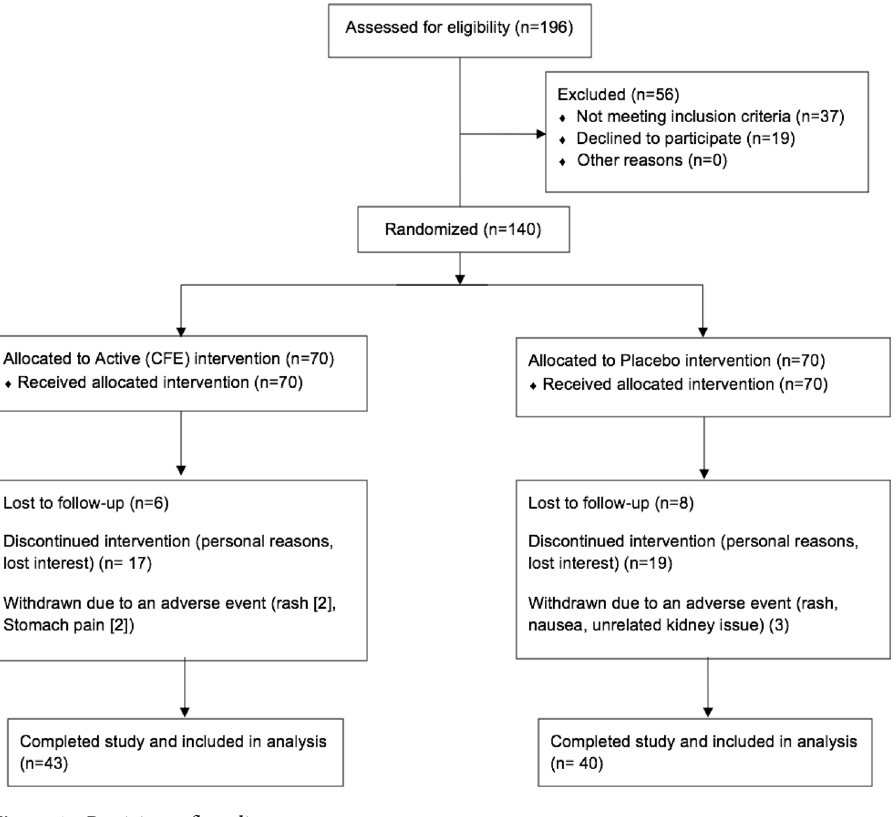
Figure 1. Participant flow